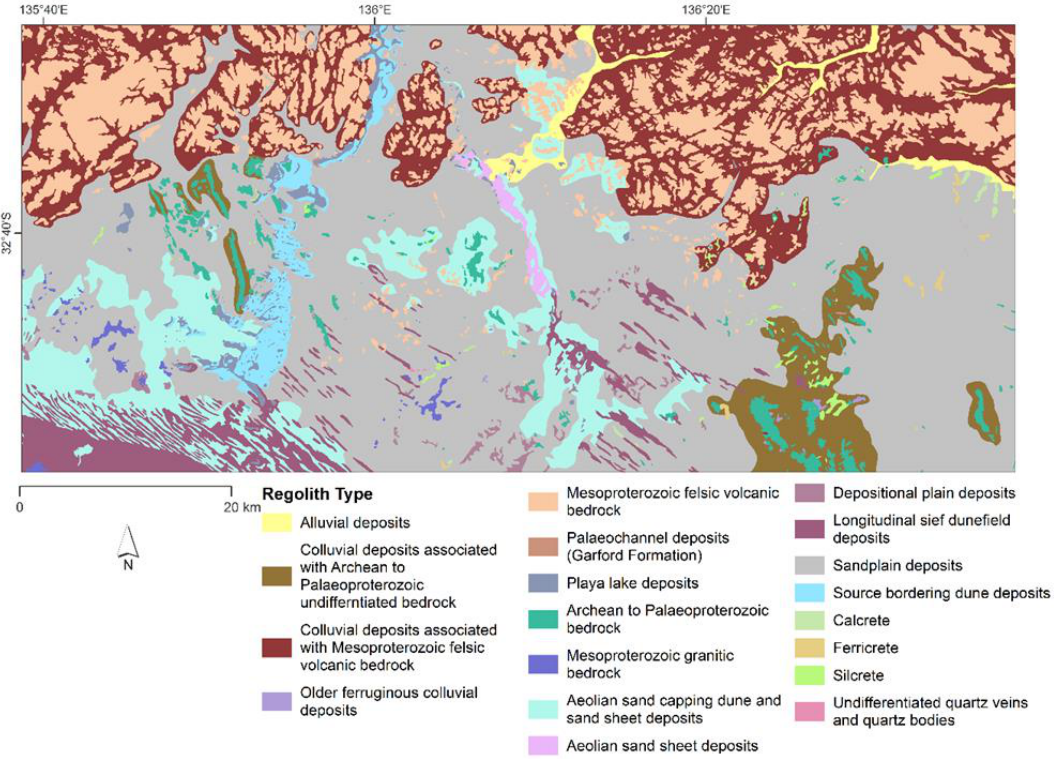
Figure 3. Regolith map of the study area. Regolith spatial data from Krapf [42].